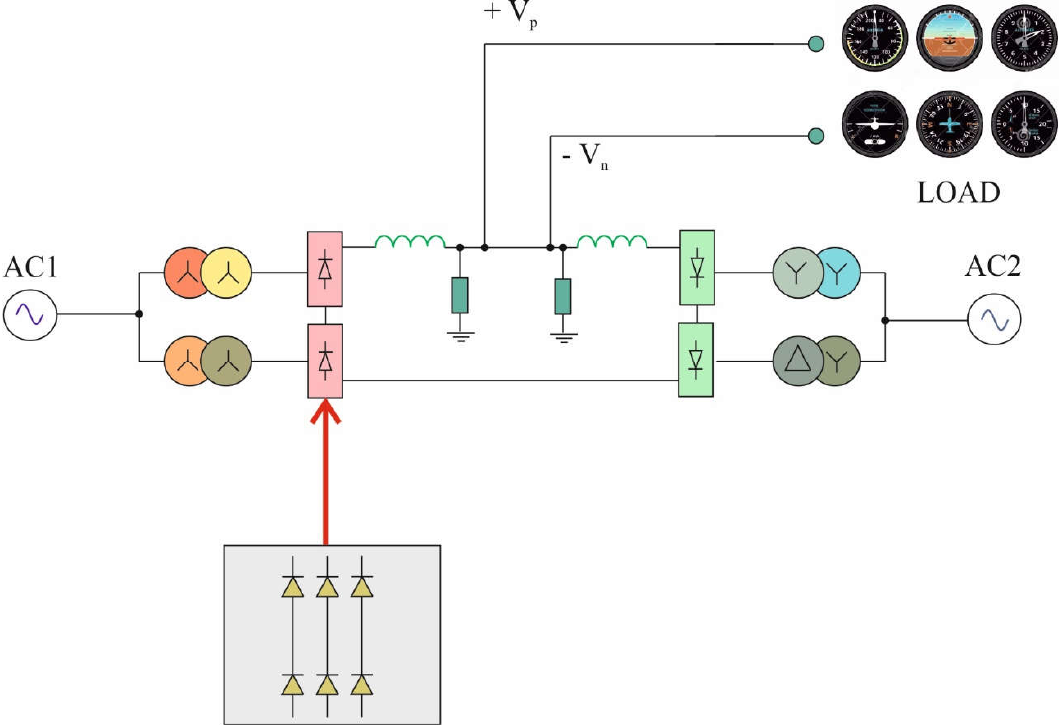
Figure 4. Diagram of a classic 36-pulse rectifier powered by a three-phase transformer.